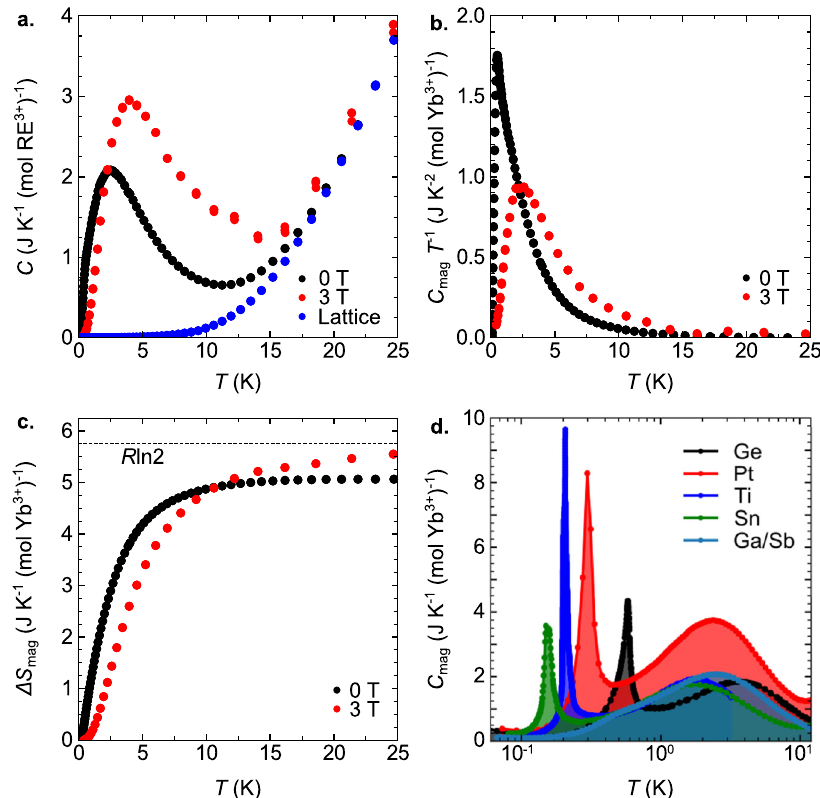
Fig. 2 Low-temperature heat capacity of polycrystalline Yb 2 GaSbO 7 . a Heat capacity of Yb 2 GaSbO 7 in zero fi eld and an applied fi eld of 3 T, with the lattice standard Lu 2 GaSbO 7 plotted for comparison. b Magnetic component of Yb 2 GaSbO 7 speci fi c heat plotted as C mag /T. c Entropy release as a function of temperature. d Comparison of C mag for Yb 2 GaSbO 7 and other Yb 3 + pyrochlores 46 – 50 . The composition of the B -site is indicated in the panel legend. Note the lack of a sharp lambda anomaly in the Yb 2 GaSbO 7